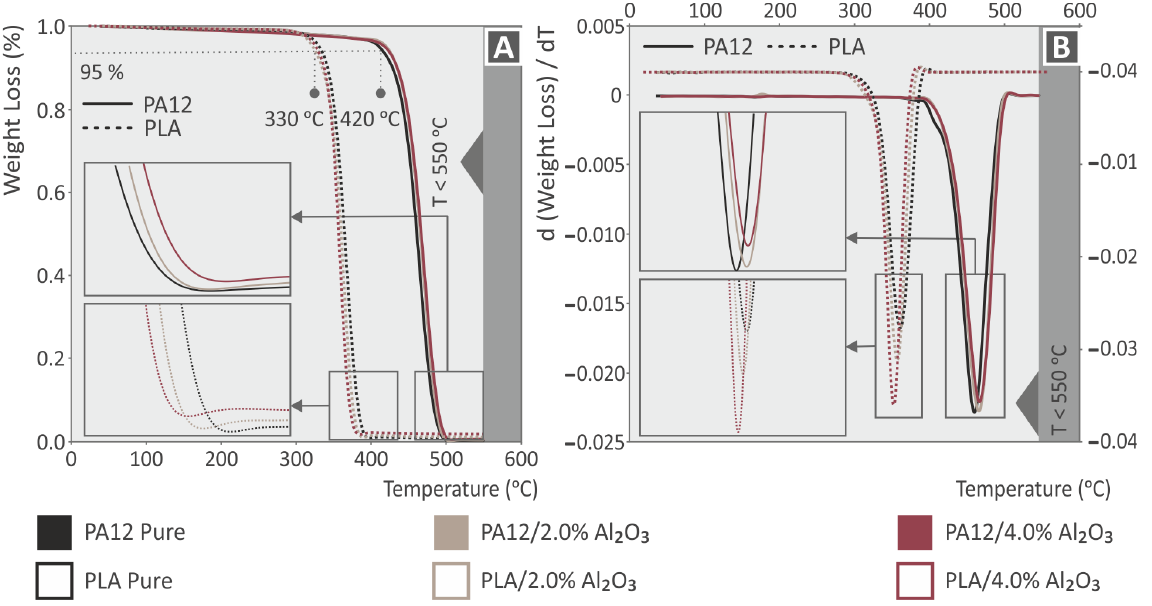
Figure 5. ( A ) Thermogravimetric analysis (TGA), and ( B ) Differential thermogravimetry (DTG) plots of 3DP printed PA12, PLA, and their Al 2 O 3 nanocomposites at 1.0, 2.0, 3.0, and 4.0 wt.% filler